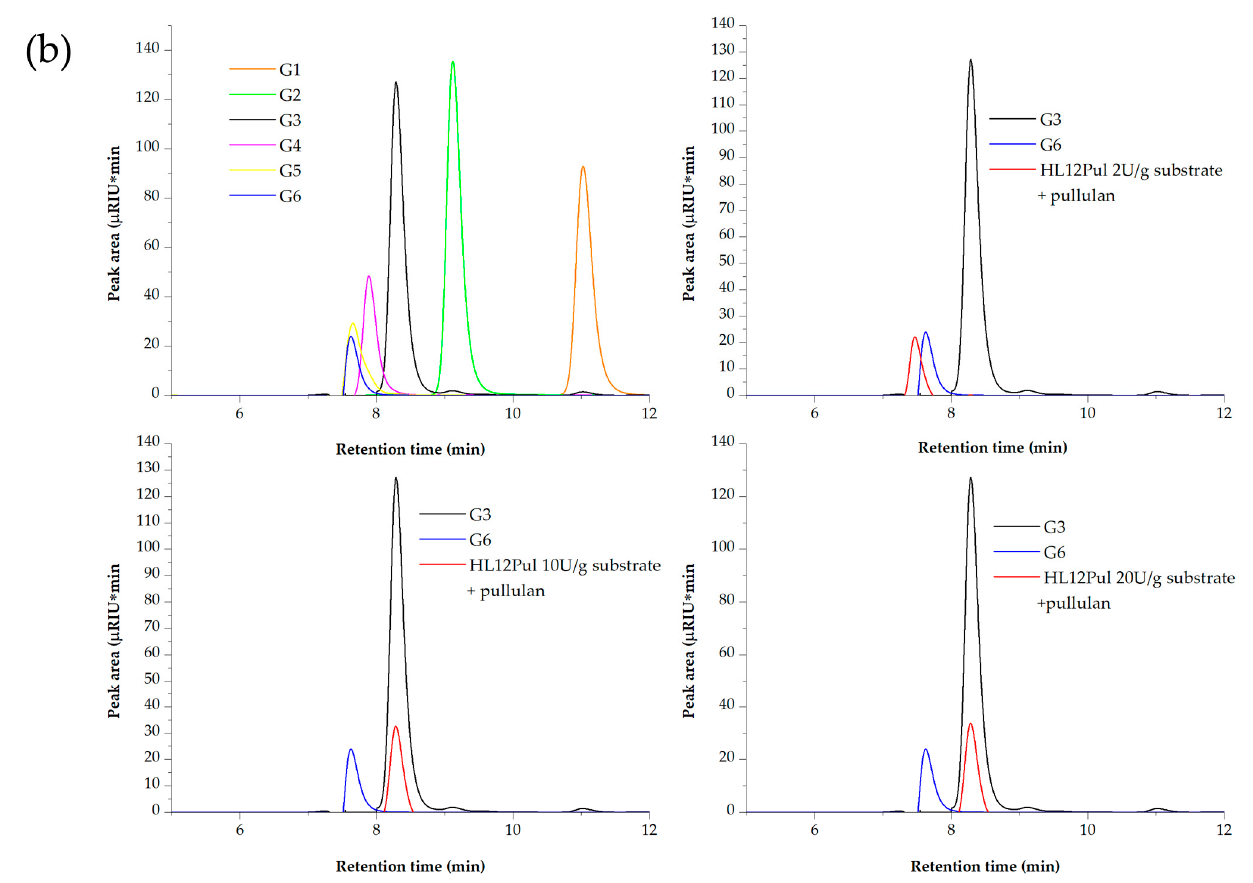
Figure 4. Verification of HL12Pul specific cleavage. ( a ) Specific cleavage of HL12Pul analyzed by the thin-layer chromatography technique. Lane 1: pullulan without enzyme; Lane 2–4: pullulan treated with 2, 10, and 20 U/g substrate of HL12Pul, respectively; Lane 5: amylose without enzyme; lane 6: amylose treated with 20 U/g substrate of HL12Pul. ( b ) High performance liquid chromatography. G1, G2, G3, G4, G5, and G6 represent glucose, maltose, maltotriose, maltotetraose, maltopentaose, and maltohexaose,